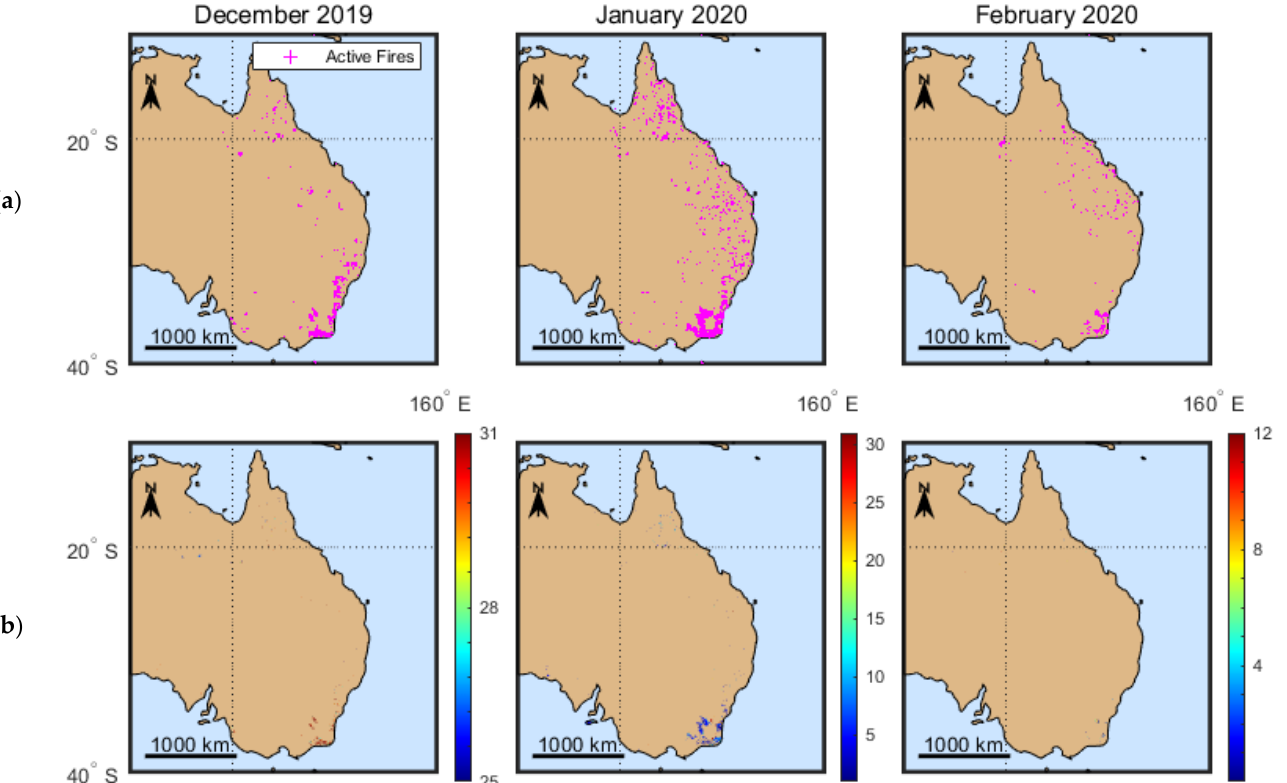
Figure 1. ( a ) Active fires and ( b ) burned area according to burn date, as obtained by MODIS for the